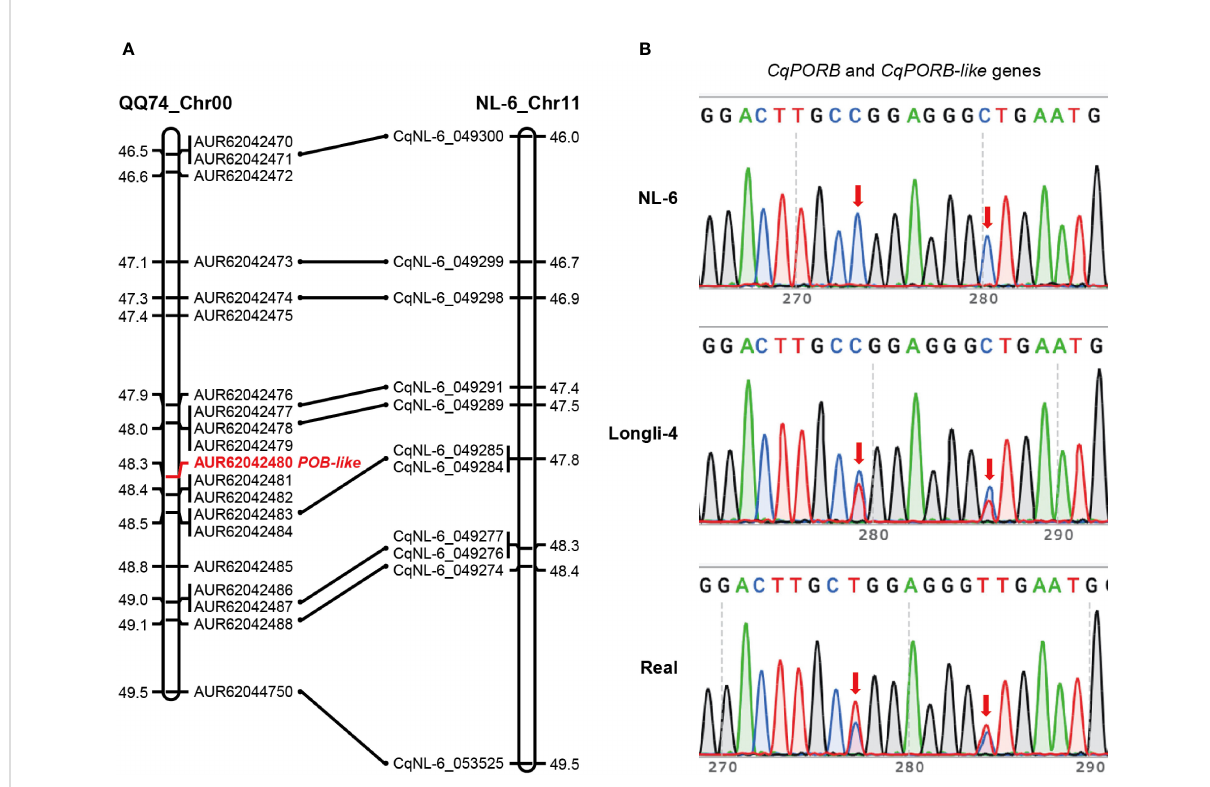
FIGURE 4 Collinearity of the CqPORB-like gene-located region between QQ74 and NL-6 varieties. (A) The CqPORB-like gene (AUR62042480) and its fl anking genes in QQ74 variety were selected to align with the collinear chromosomal region in NL-6 variety. Note that CqPORB-like gene is lost in the NL-6 genome. (B) PCR ampli fi cation of CqPORB and CqPORB- like genes using a pair of primers matched to both genes in NL-6, Longli-4, and Real varieties. The PCR products were sequenced by sanger sequencing. Arrows indicate the variations between CqPORB and CqPORB-like